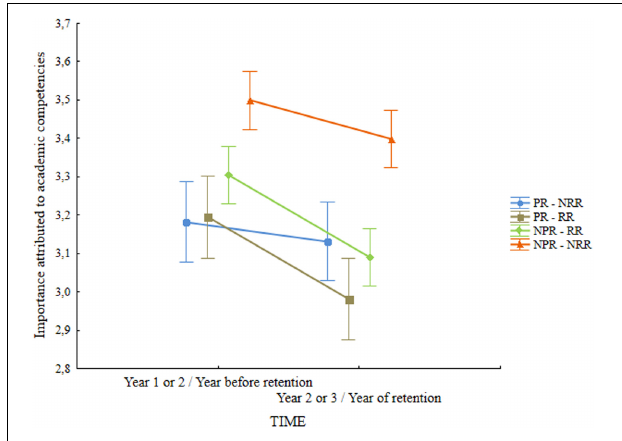
FIGURE 2 | Retention status × time interaction for the Importance given to academic competence. Vertical bars denote 0,95 confidence intervals. PR – NRR, group with past but no recent retention; PR – RR, group with past and recent retention; NPR – RR, group with no past but recent retention; NPR – NRR, group with no past or recent